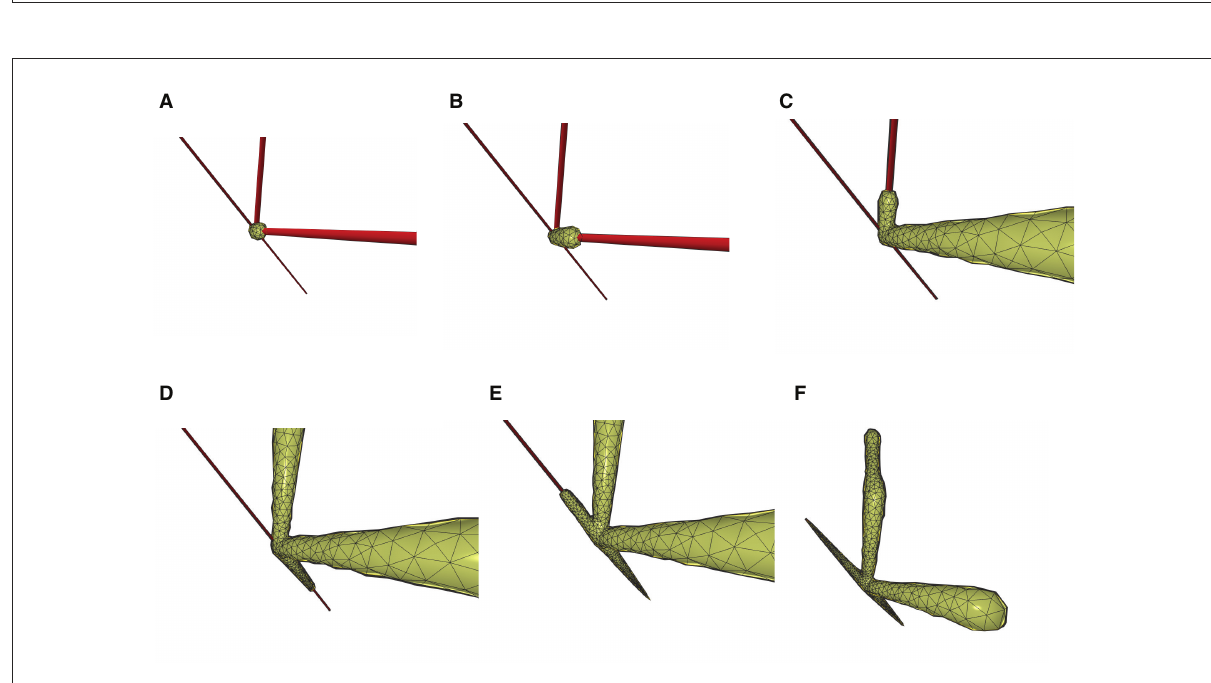
FIGURE3 The iterative deformation process. (A) An initial spherical mesh placed at the root node. (B–F) Generation of the gradually evolved mesh structure driven by the neuronal